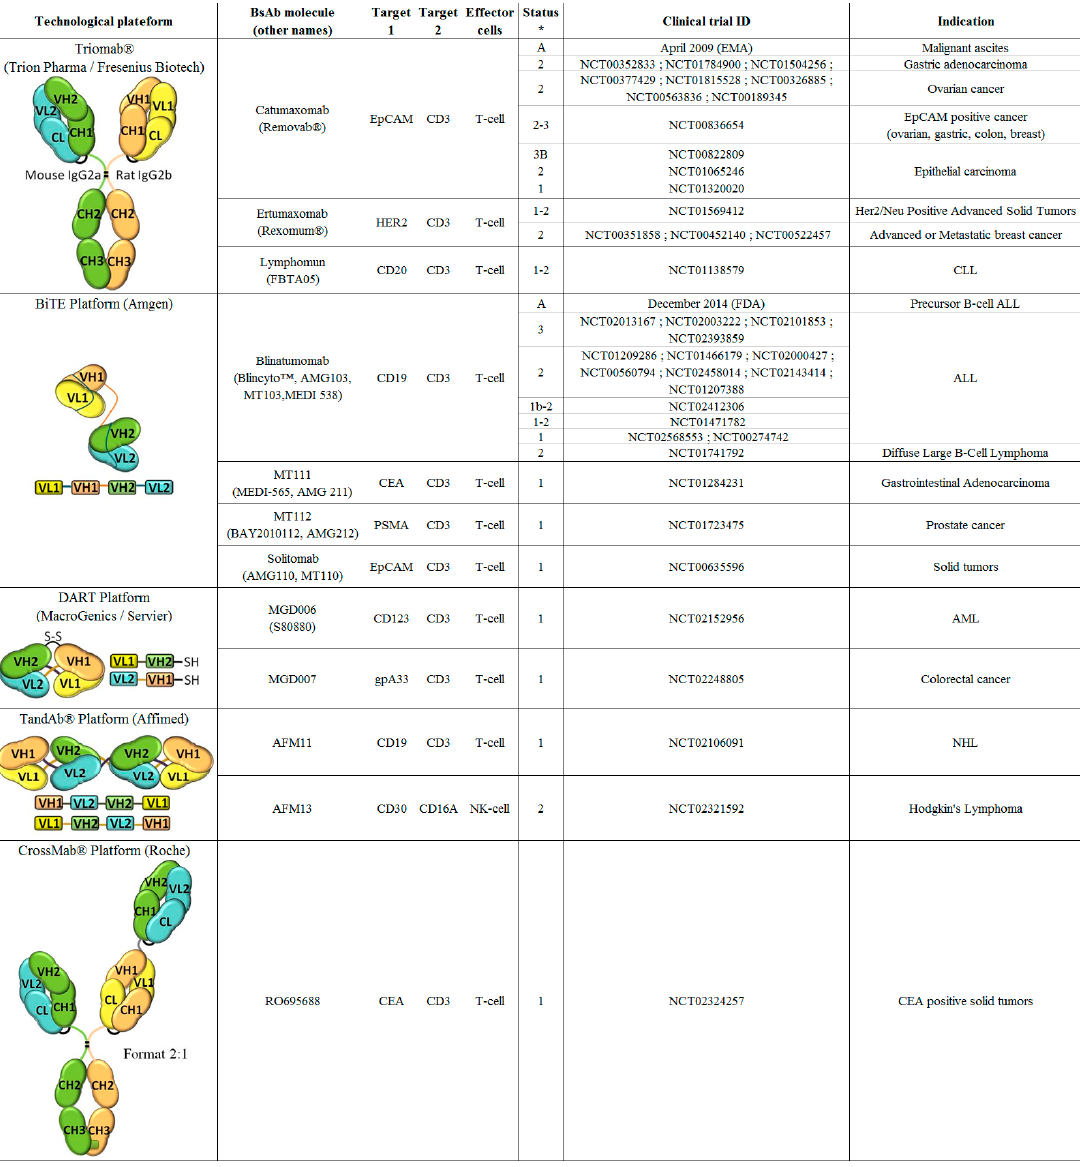
Figure 1. Bispecific antibodies targeting immune cells, approved or in clinical trials. A: Approved; 1, 2, 3: Phases of clinical